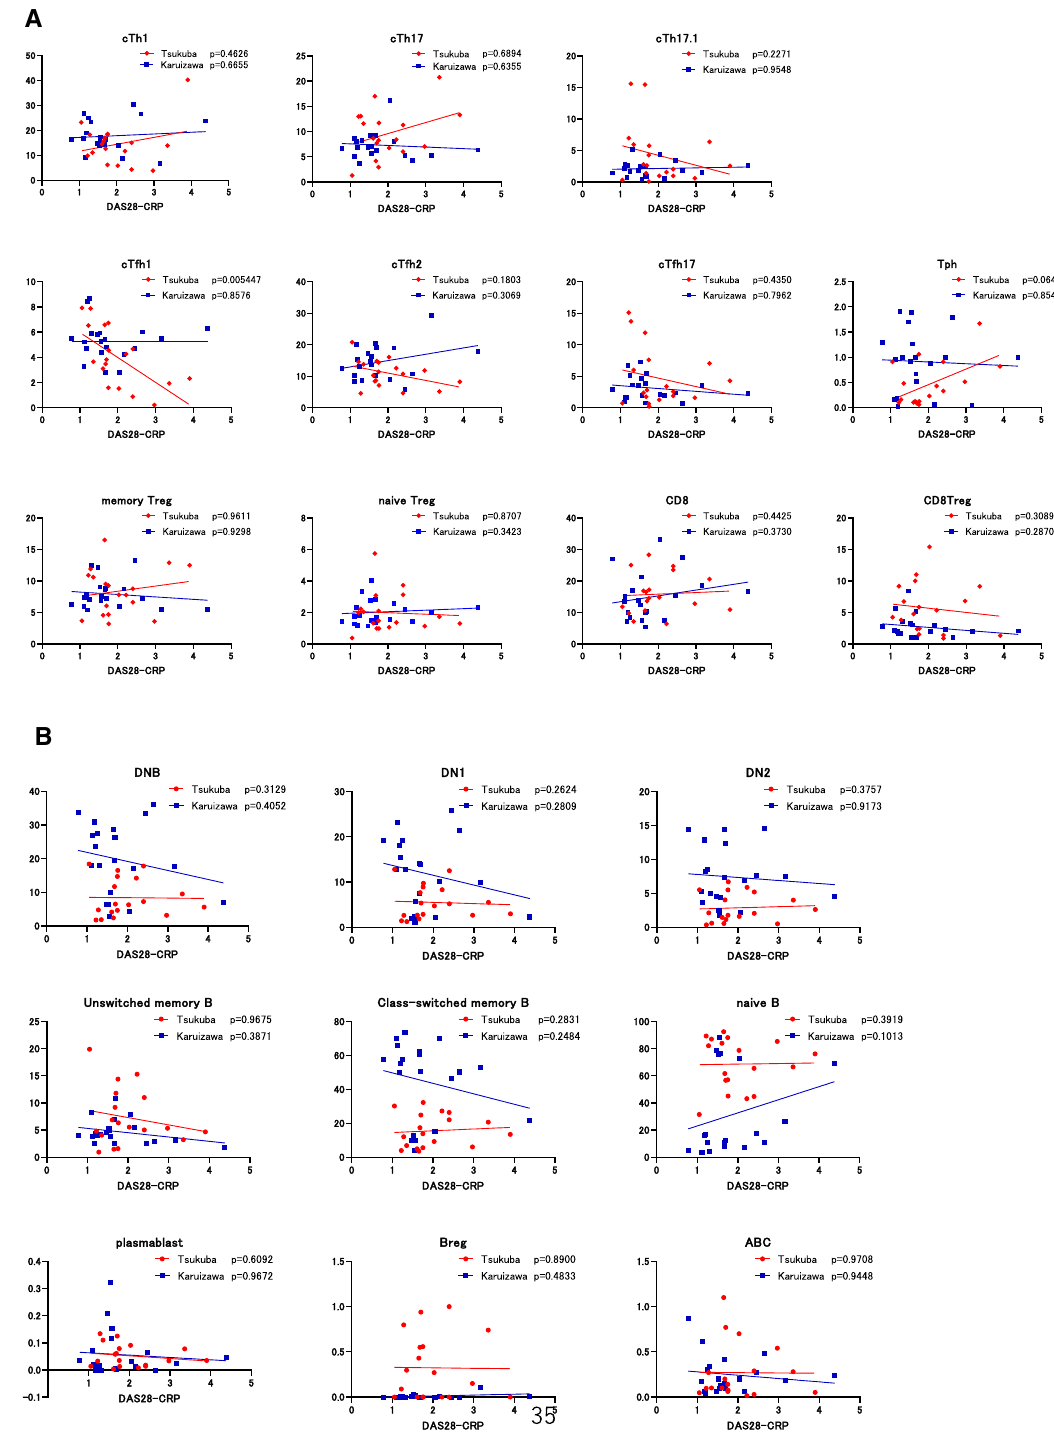
Figure 5. Correlation between T cell or B cell subpopulations and disease activity in RA patients. Correlation between disease activity of RA and proportion of the subpopulations in T cells ( A ) and B cells ( B ) in PBMCs collected from Tsukuba and Karuizawa were analyzed. Correlation analysis was performed using Spearman rank correlation